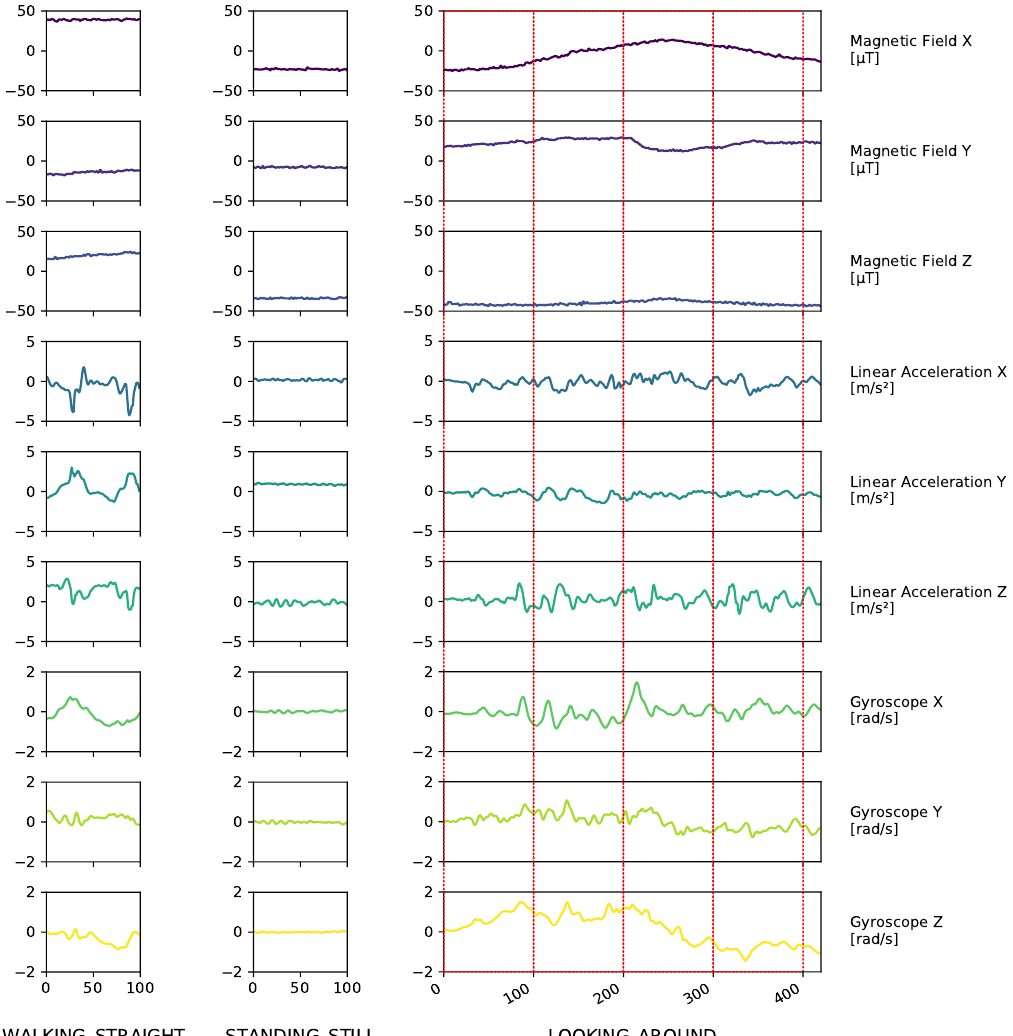
Figure 5. Examples of raw data for different activities collected in the Activity Logs Dataset. Red regions in the right-most graph illustrate how a stream of continuous data is split into 1-s windows consisting of 100 sensor readings